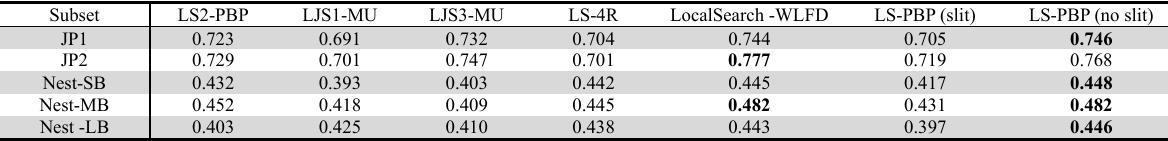
Comparison with other literature about F